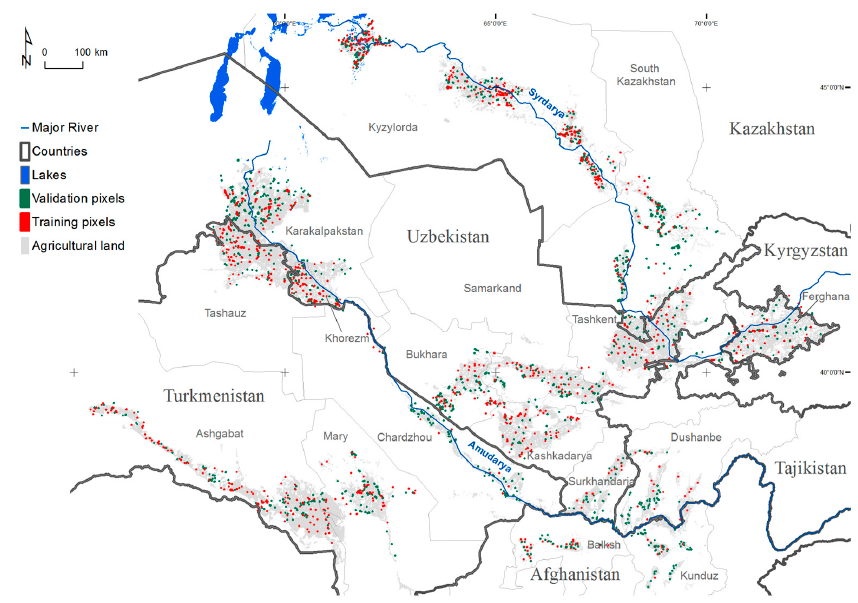
Figure 3. Location of training (red) and validation (green) pixels for determining abandoned vs. active cropland.